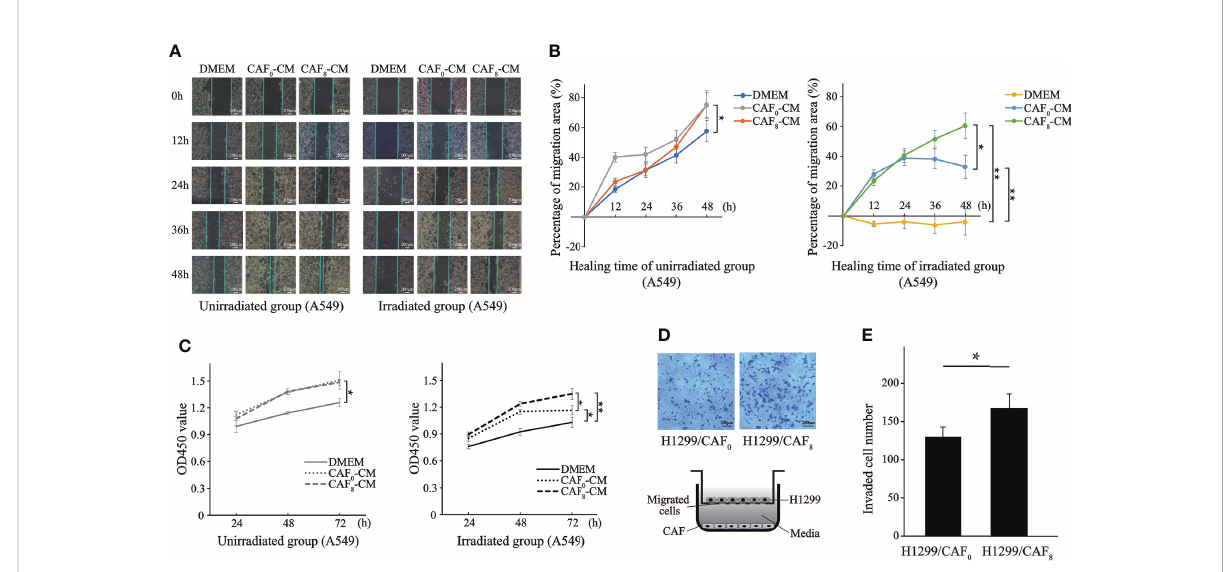
FIGURE 4 CAFs ’ conditioned medium (CM) promoted proliferation and migration of lung cancer cells after ionizing irradiation. (A) Representative images of wound healing assay for the A549 cells in irradiated group and unirradiated group treated with DMEM, CAF 0 -CM, and CAF 8 -CM; (B) Quanti fi cation of the change in healing area (%) over time in different subgroups; (C) Differences in the proliferation of A549 after irradiation with or without 6Gy in different conditioned medium were analyzed by the CCK8 assay; (D) Transwell assay analyzed the migration of H1299 cells co-cultured with CAF 0 and CAF 8 ; (E) The histogram showed the number of transmembrane H1299 cells in two groups. (T-test, data are presented as the mean ± S.D. * P < 0.05, ** P < 0.01).